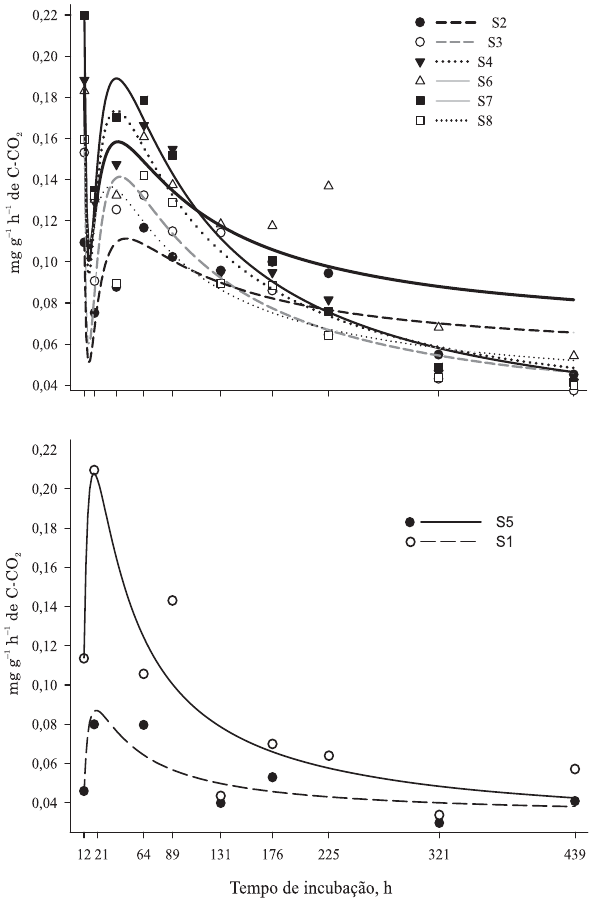
Figura 2. Taxas respiratórias de serapilheira, solo e diferentes combinações serapilheira/solo de Pinus elliottii e Terminalia ivorensis . S1 – solo/